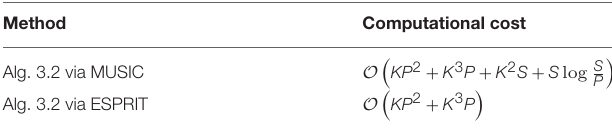
TABLE 3 | Computational cost of one iteration step of Algorithm 3.2 in the case of (2 K + 1) P given samples (3.1) .